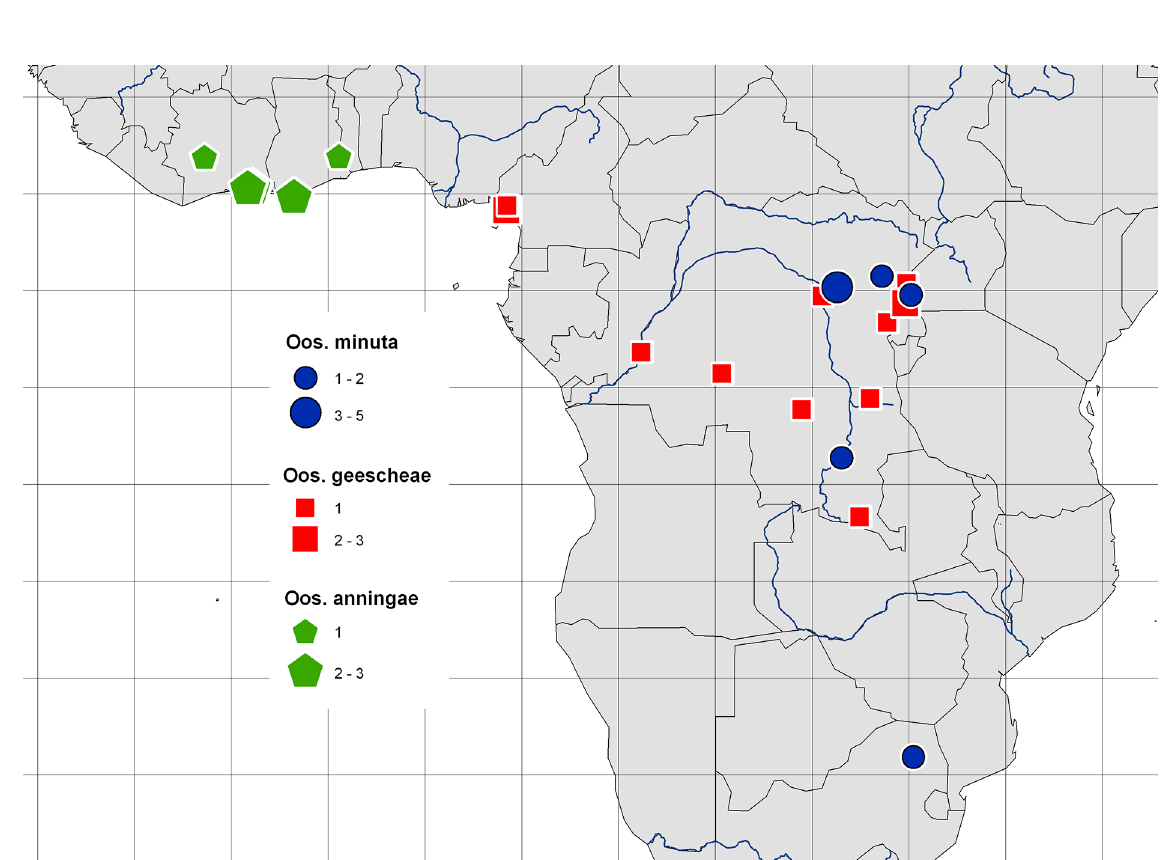
Fig. 13. Distribution of O. minuta comb. nov., O. anningae sp. nov. and O. geescheae sp.